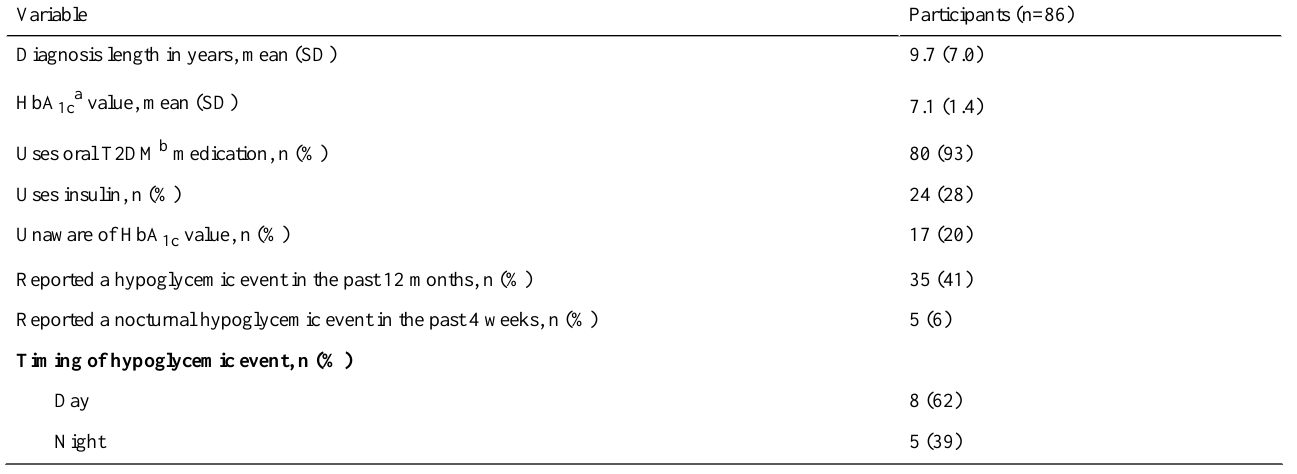
Table 2. Type 2 diabetes mellitus characteristics and mode of disease